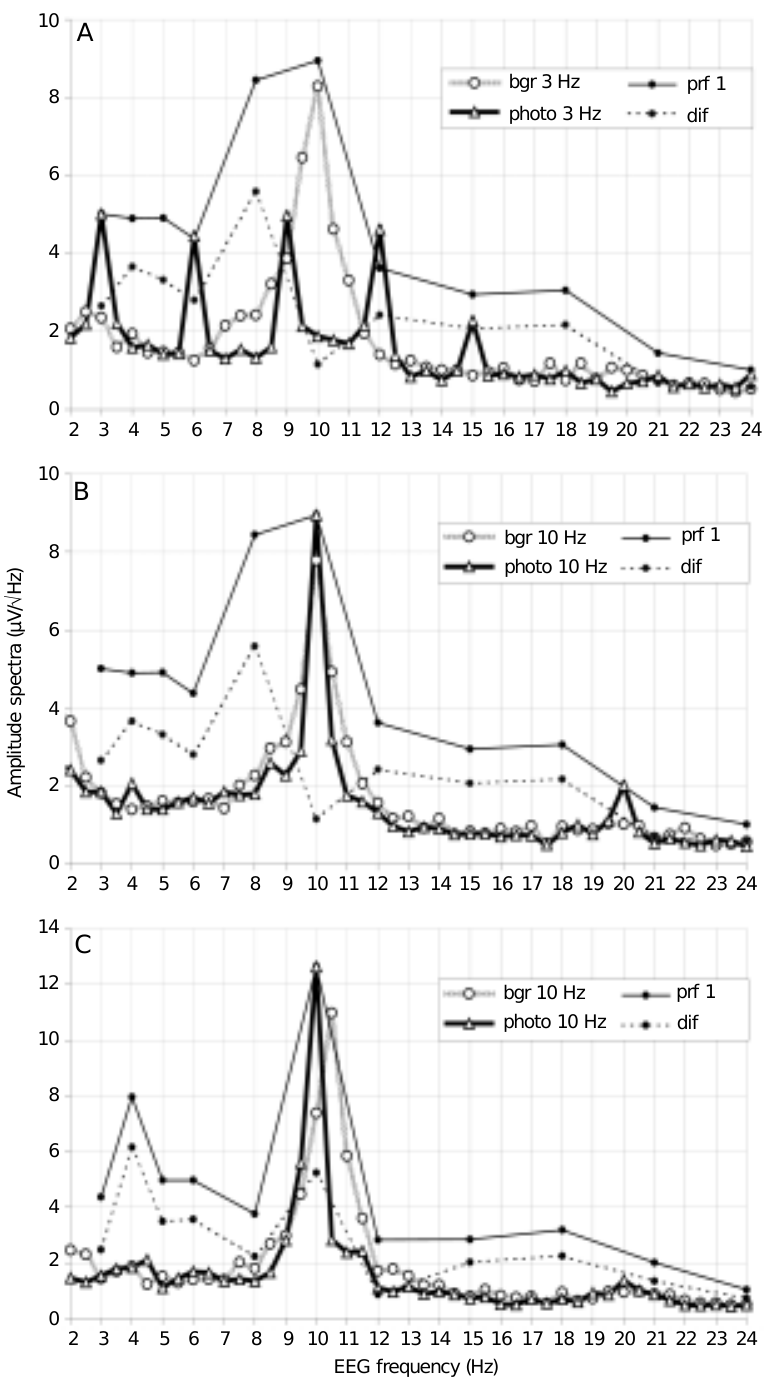
Figure 2. EEG spectra for individual subjects in the first series of intermittent photic stimulation (IPS), in the resting state (bgr) and during IPS (photo), together with the driving profiles (prf 1) and “difference” profiles (dif), showing an increase in the amplitude spectra at each frequency of IPS in relation to the background. A , Subject MA, and IPS of 3 Hz (for spectrum). B , Subject MA, and IPS of 10 Hz (for spectrum). C , Subject TI, and IPS of 10 Hz (for spectrum). The abscissae show the EEG